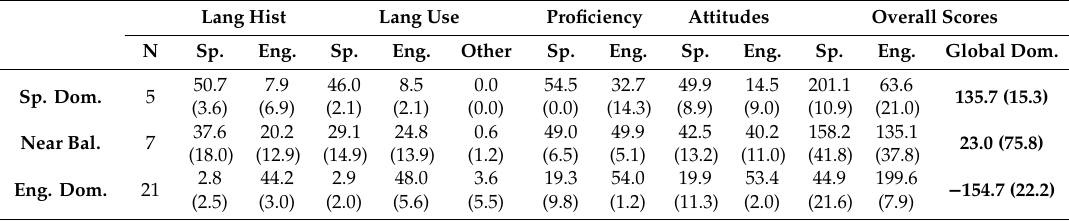
Table 1. BLP language dominance results for Spanish-dominant group (n = 5), near-balanced group (n = 7), and English-dominant group (n = 21). Lang Hist Lang Use Proficiency